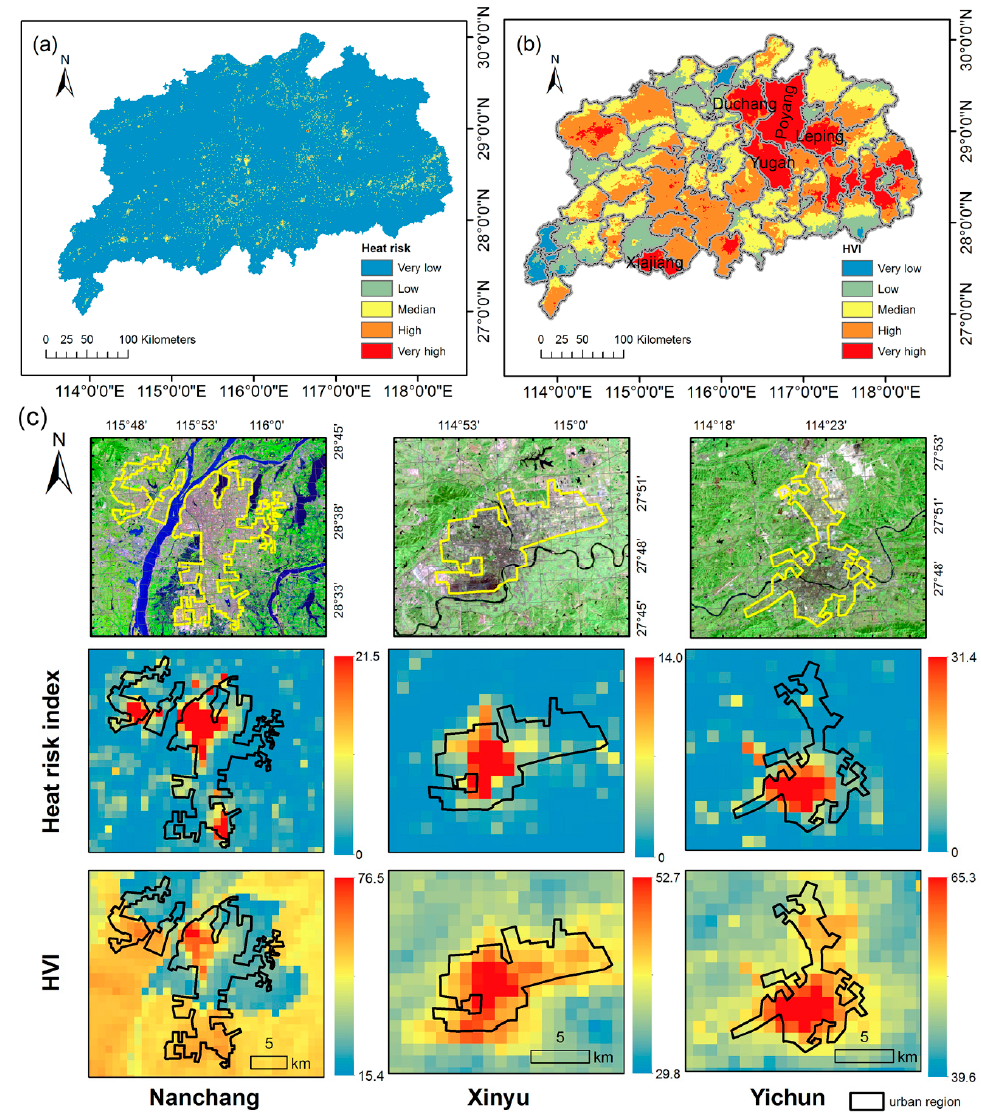
Figure 7. ( a ) spatial distribution of heat risk under Crichton’s risk triangle framework; ( b ) spatial distribution of high-temperature vulnerability index under HVI framework. ( c ) three selected main urban regions (Nanchang, Xinyu and Yichun) and their spatial distributions of heat risk index and